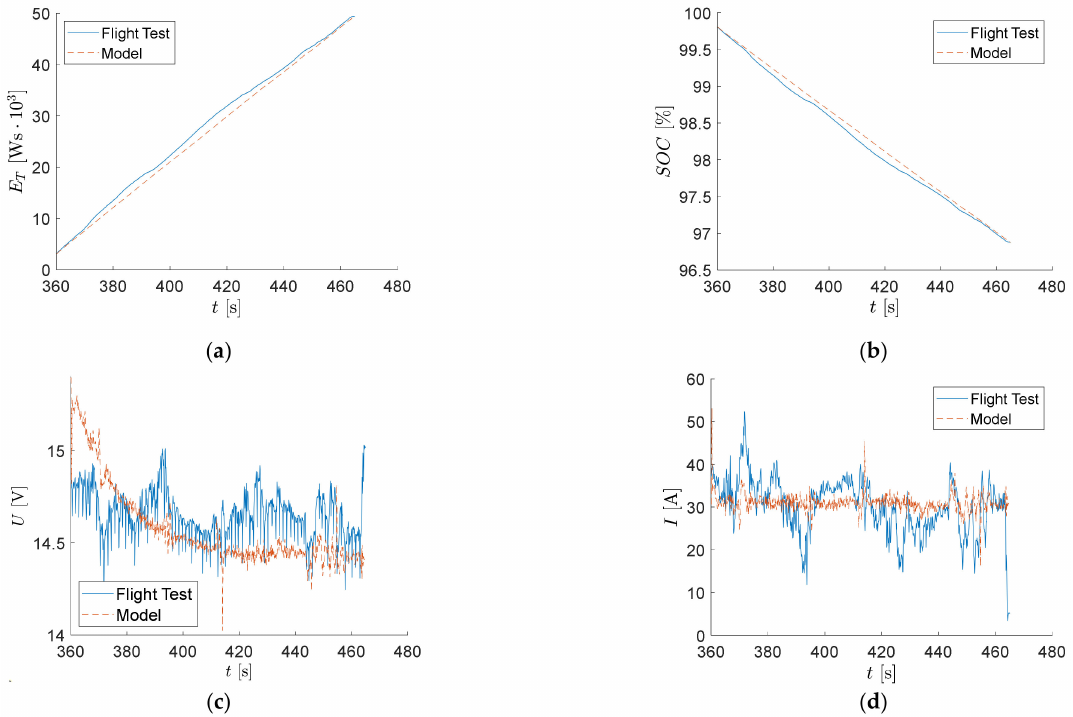
Figure 15. Energetic model: ( a ) total energy consumed by the drone, ( b ) battery state of charge, ( c ) voltage, and ( d )